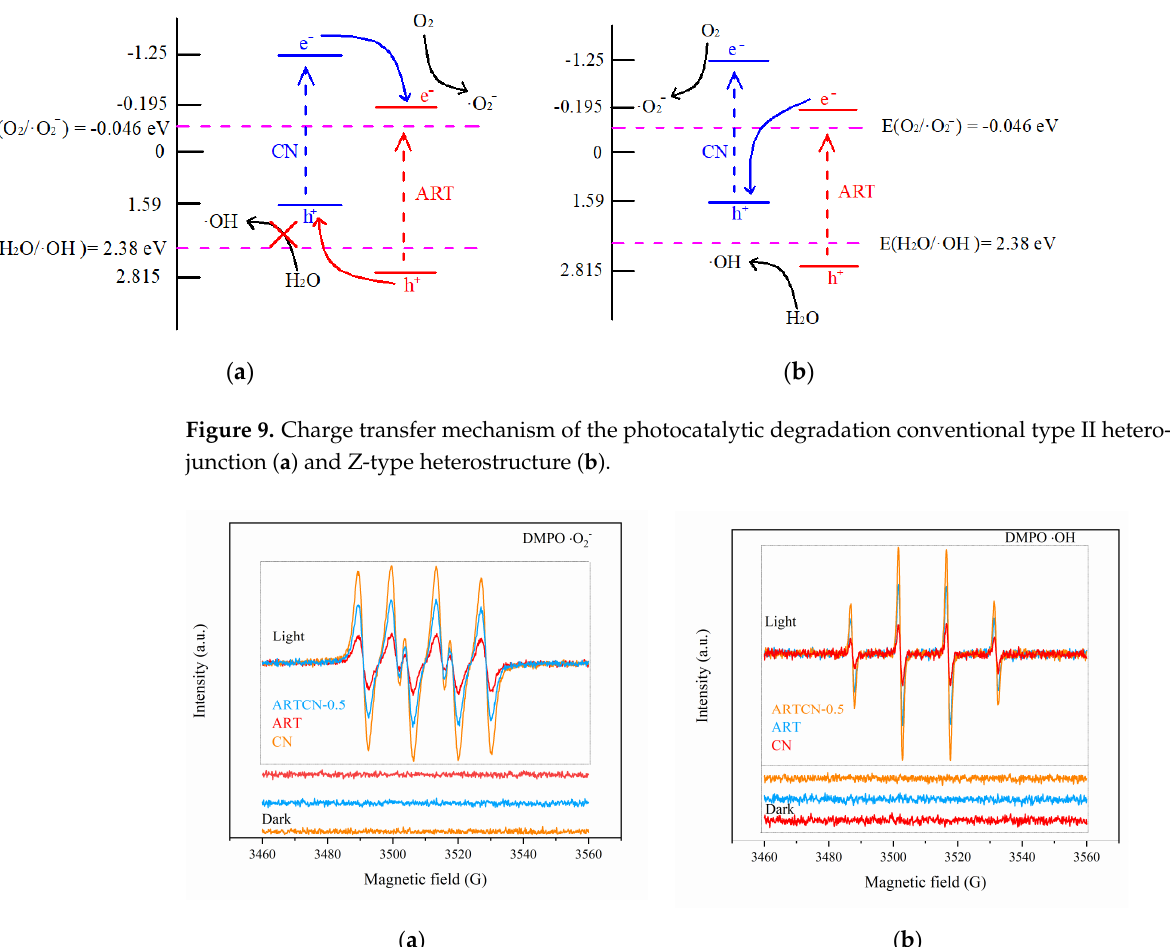
Figure 11. EIS spectra of the samples. 3.2. Photocatalytic Degradation Mechanism Discussion ESR was used to detect the types of free radicals in the catalysts under light, and then we explored their degradation mechanism of ammonia. As shown in Figure 10a,b, ART, CN, and ARTCN-0.5 did not produce free radicals in the absence of light, and superoxide free radicals (·O 2− ) and hydroxyl free radicals (·OH) were detected after light exposure. ·O 2− and ·OH played decisive roles in the entire reaction [50]. The degradation mechanism was as follows. After gaseous ammonia combined with moist air, NH 4+ was present as